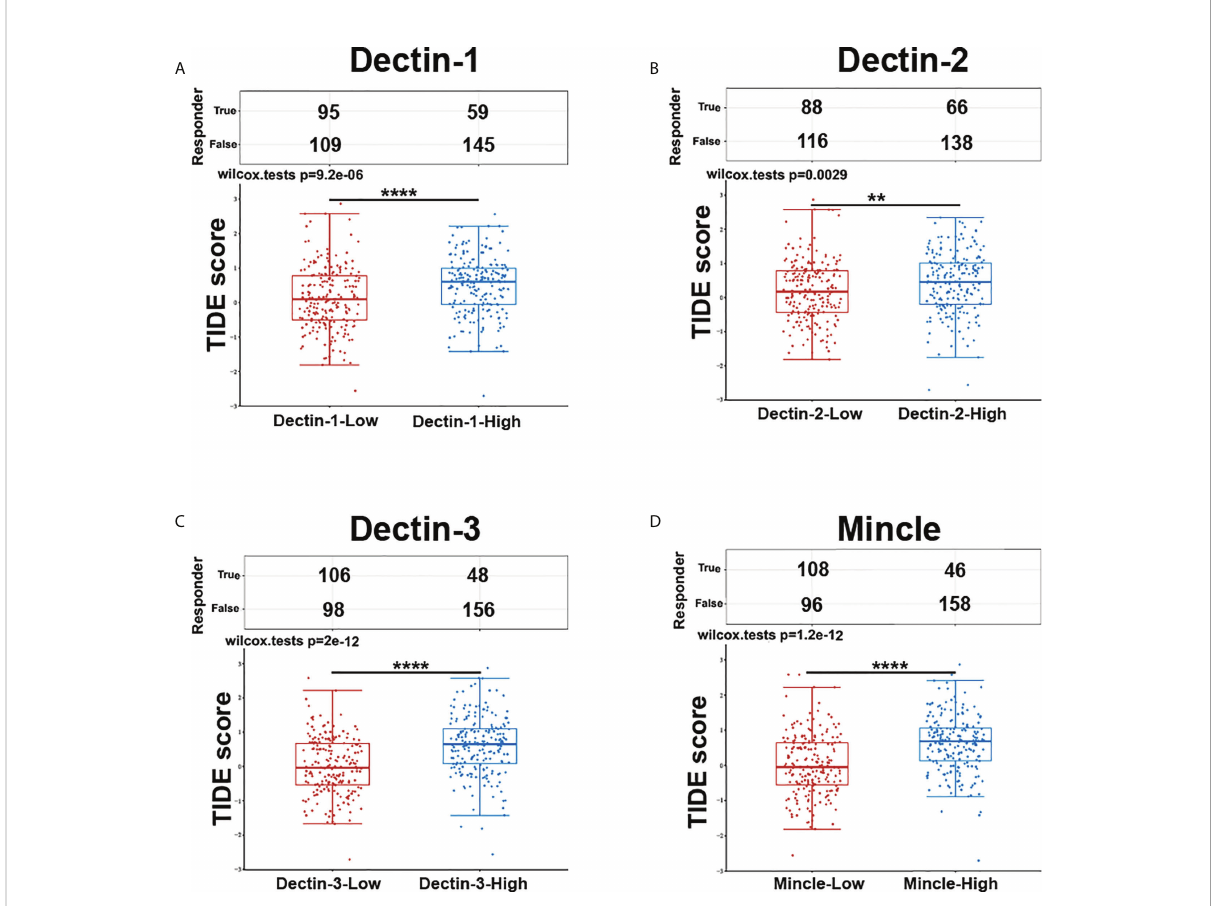
FIGURE 6 Prediction of response to ICB therapy between bladder cancer patients in the CLR-high and CLR-low groups ( A . Dectin-1, B . Dectin-2, C . Dectin-3, D . Mincle). The enrolled bladder cancer patients (n = 406) were divided equally into two groups based on median transcript expression levels of CLRs. Patients in the CLR-high group had consistently higher TIDE scores than those in the CLR-low group. *p < 0.05, **p < 0.01, ***p < 0.001, ****p < 0.0001. The statistical differences between the two groups were compared using a Wilcox